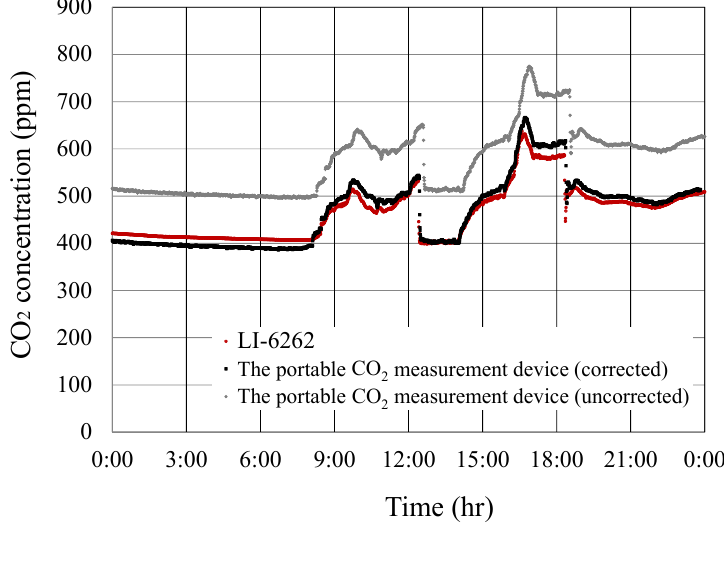
Figure 8. Comparison of CO device and LI-6262 on 7 February